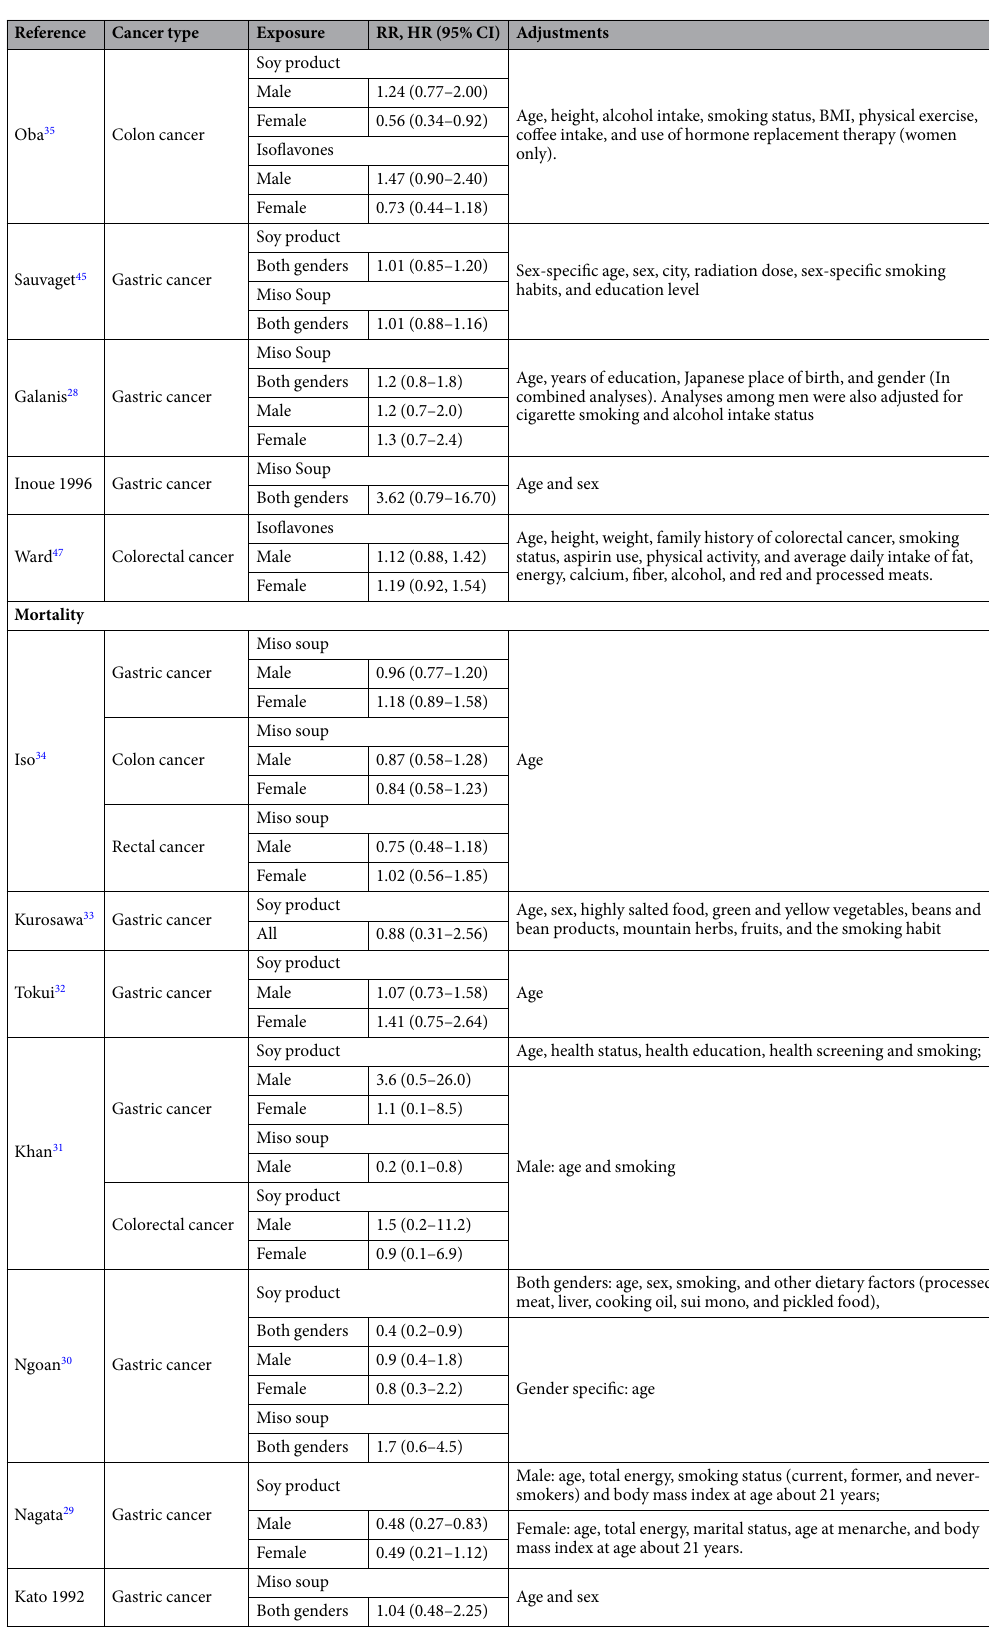
Table 2. The exposure type specific and gender specific risk estimates of GI cancer and soy consumption. RR: Relative Risk; HR: Hazard Ratio; CI: Confidence Intervals; BMI: Body Mass